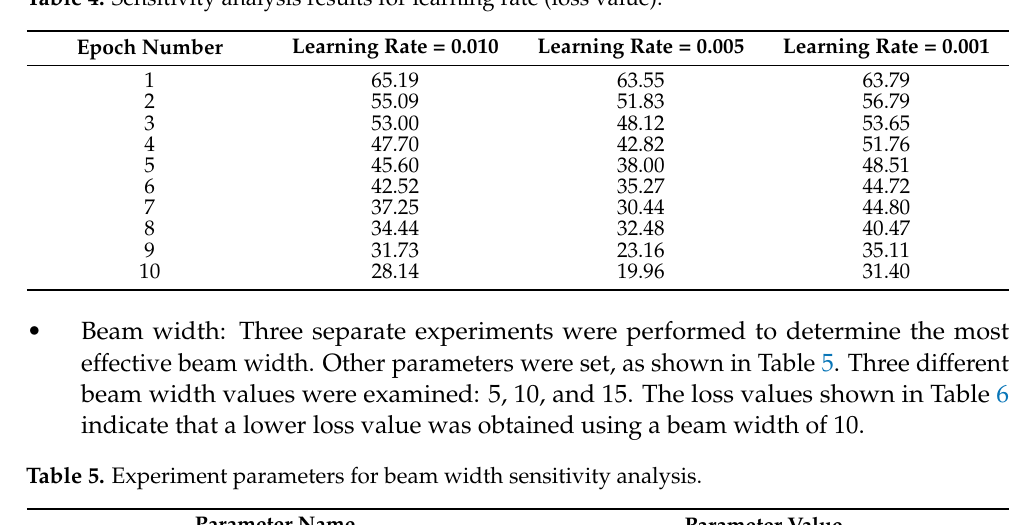
Table 4. Sensitivity analysis results for learning rate (loss value).